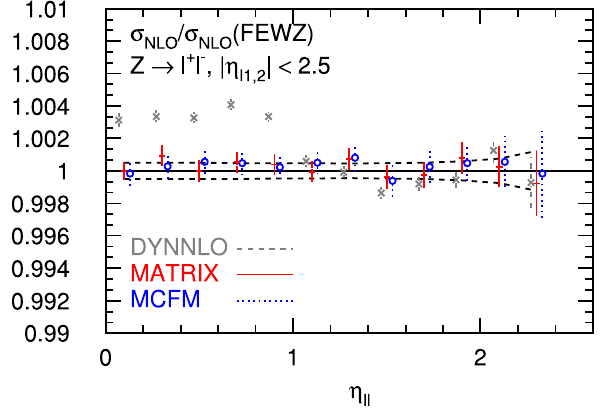
Fig. 2 Same as Fig. 1 for the NLO QCD cross sections for pp → √ Z /γ ∗ + X → l + l − + X production at s = 7 TeV as function of the pseudo-rapidity η ll . Cuts of p T 1 , 2 ≥ 25 GeV, 66 ≥ M ll ≥ 116 GeV | ≤ 2 . 5, i = 1 , 2 for the lepton pseudo-rapidities are applied and | η l i